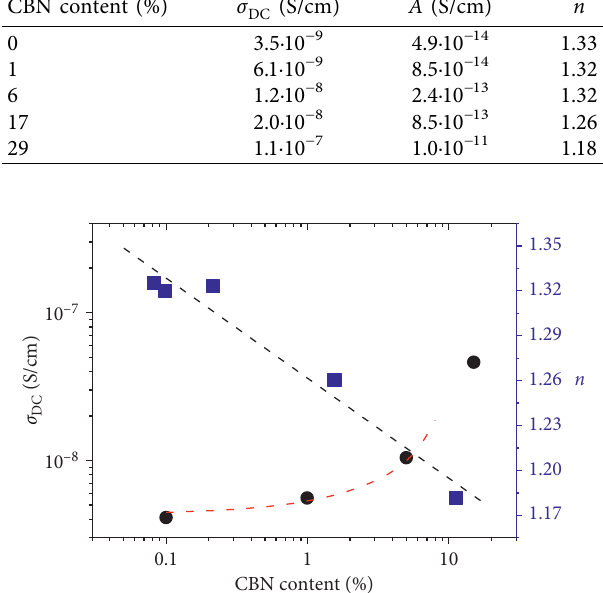
Table 1: Parameters of Jonscher’s model (equation (1)). CBN content (%)